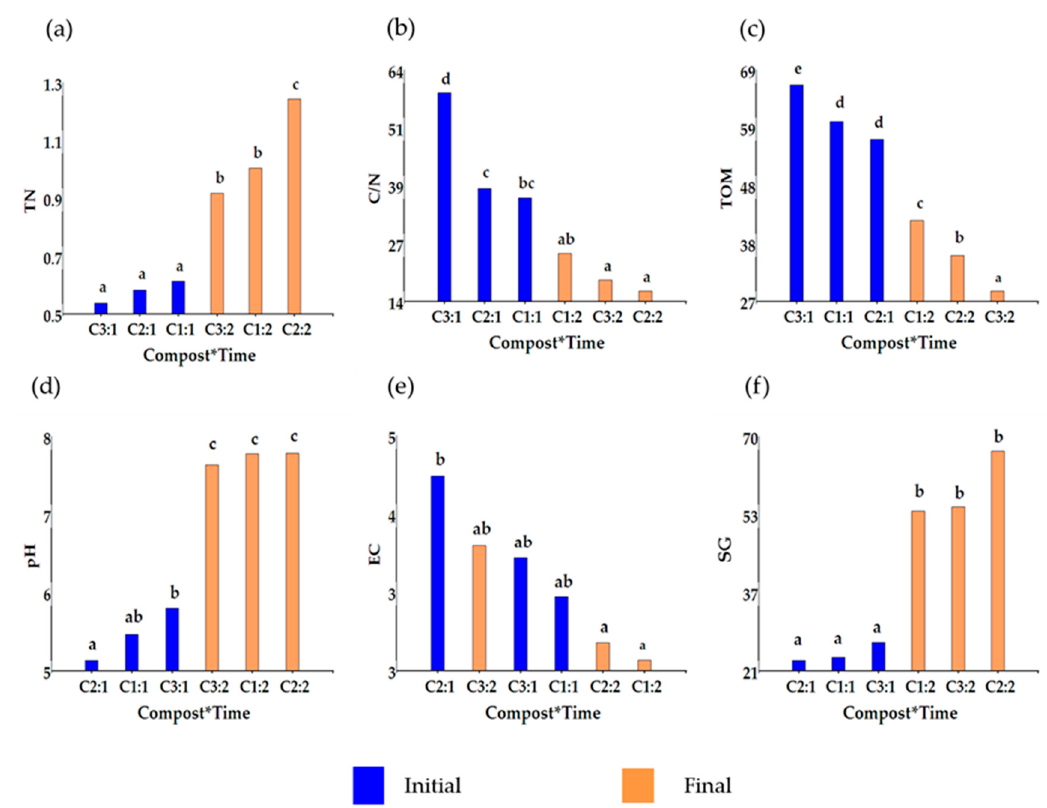
Figure 4. Initial and final values of TN ( a ), C/N ( b ), TOM ( c ), pH ( d ), EC ( e ) and SG ( f ). Values are the average of three replications. Different letters indicate significant differences according to the one-way ANOVA test ( p < 0.05). TN: total nitrogen; C/N: carbon nitrogen ratio; TOM: total organic matter; EC: electrical conductivity; SG: stability grade.